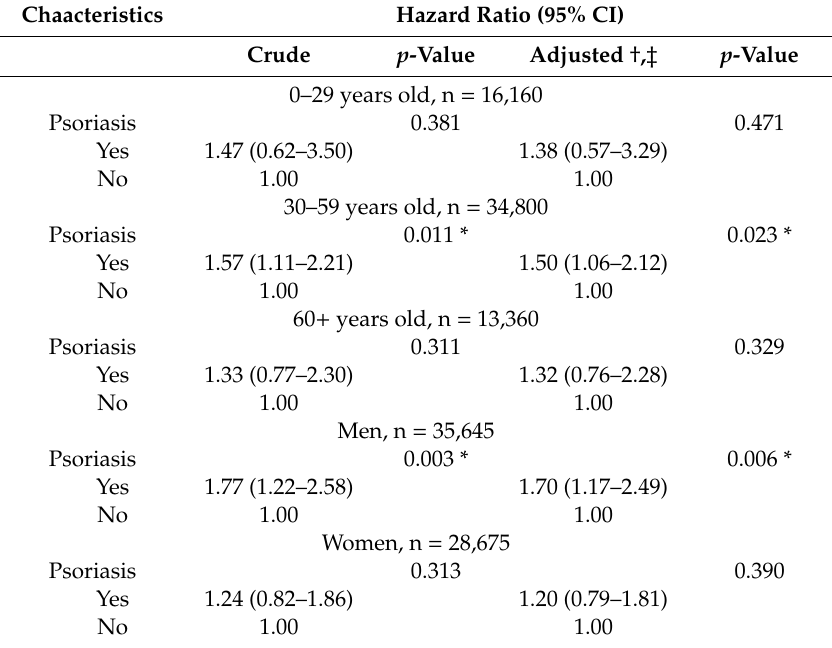
* Cox-proportional hazard regression model, significance at p < 0.05; † stratified model for age, sex, income, and region of residence; ‡ adjusted model for Charlson comorbidity